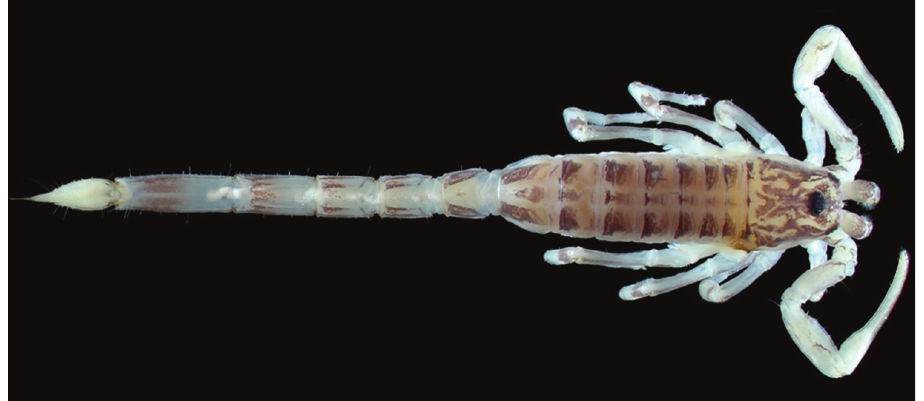
Figure 3. Ananteris intermedia , male holotype from St. Jean du Maroni (photo MNHN / E.-A. Leguin; 2012 Elsevier Masson